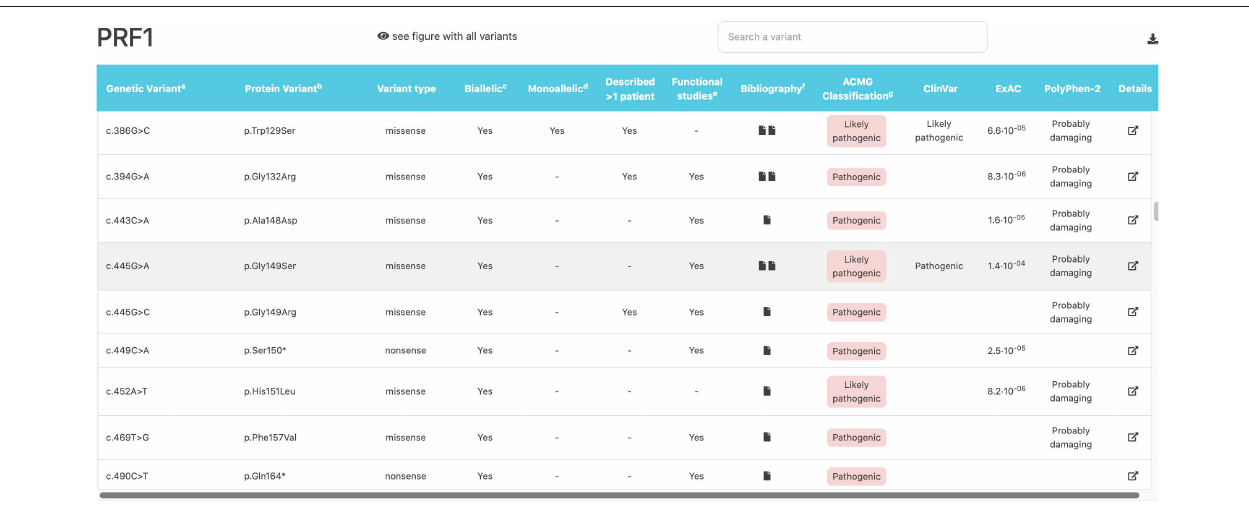
Frontiers in Immunology |